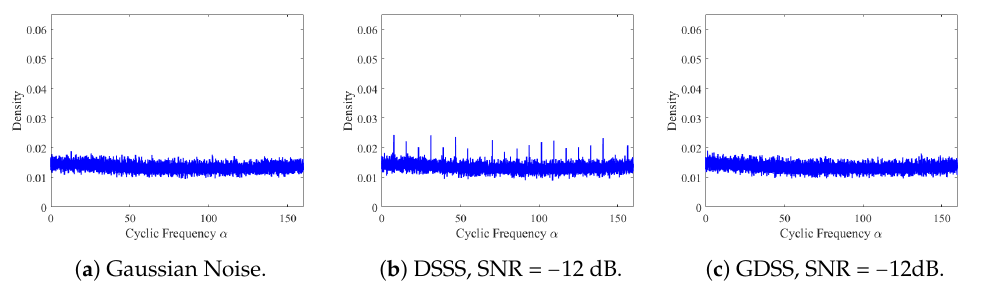
Figure 10. Spectral correlation spectrum for various signals, N =